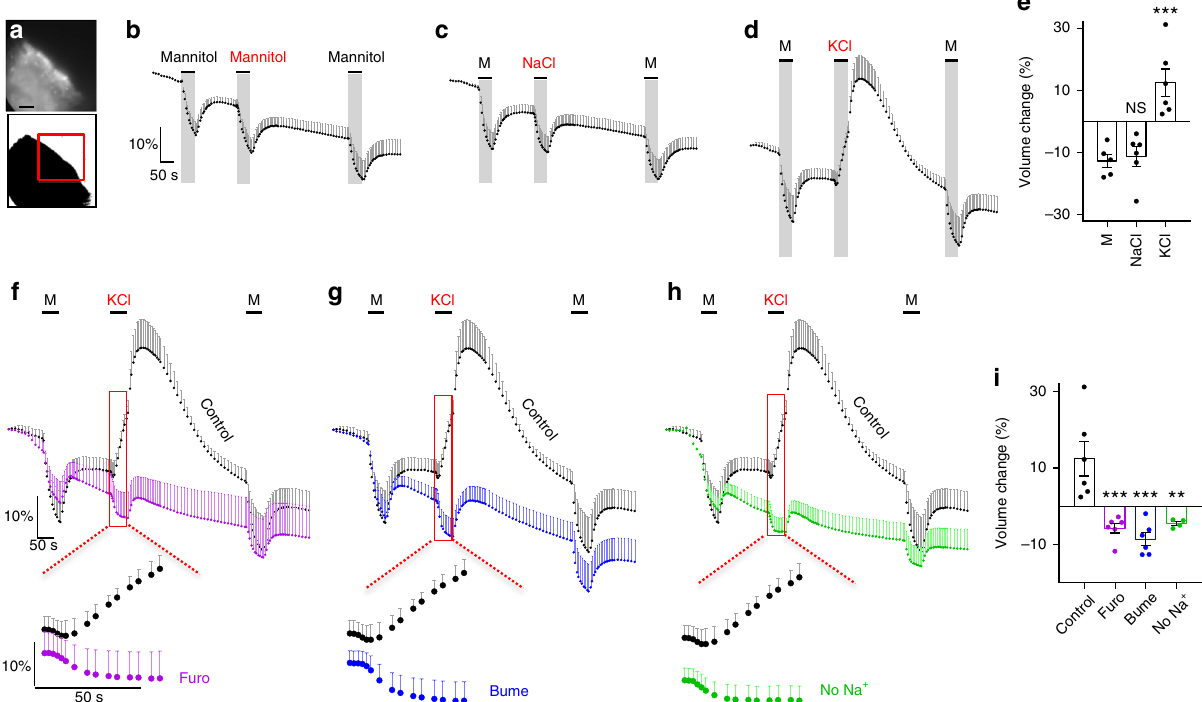
Fig. 1 Cotransporter-mediated active water transport against an osmotic gradient. a Image of calcein fl uorescence in mouse choroid plexus (CP, top) and the converted image (bottom) with indication of the region of interest (red box). Scale bar = 60 µ m. b Volume changes of CPs challenged with a 100 mOsm gradient of mannitol (M), indicated by the extended bars ( n = 5 CPs from fi ve mice). c CPs challenged with a 100 mOsm gradient of fi rst mannitol (M), then NaCl, and fi nally mannitol, indicated by the extended bars ( n = 6 CPs from six mice). d CPs challenged with a 100 mOsm gradient of fi rst mannitol (M), then KCl, and fi nally mannitol, indicated by the extended bars ( n = 6 CPs from six mice). e Summary of the second volume change induced by identical osmotic gradients. f CPs challenged with 100 mOsm KCl alone (control, black symbols, data from d ) or in the presence of 1 mM furosemide (purple symbols, n = 6 CPs from six mice). Inset magni fi es the area of interest where furosemide blocks the KCl-induced swelling. g CPs challenged with 100 mOsm alone (control, black symbols, data from d ) or in the presence of 10 µ M bumetanide (blue symbols, n = 6 CPs from six mice). Inset magni fi es the area of interest where bumetanide blocks the KCl-induced swelling. h CPs challenged with 100 mOsm KCl (control, black symbols, data from d ) and in the absence of Na + in the test solution (green symbols, n = 4 CPs from four mice). Inset magni fi es the area of interest where lack of Na + blocks the KCl- induced swelling. i Summary of the second volume change induced by KCl alone or with drug application/Na + omission. Error bars represent standard error of the mean and statistical signi fi cance was tested with one-way ANOVA followed by Tukey ’ s multiple comparisons test. In panel e , the asterisks refer to a comparison to the mannitol-mediated shrinkage and in panel i , the asterisks refer to a comparison to the KCl-mediated swelling. ** P < 0.01, *** P < 0.001, NS not signi fi